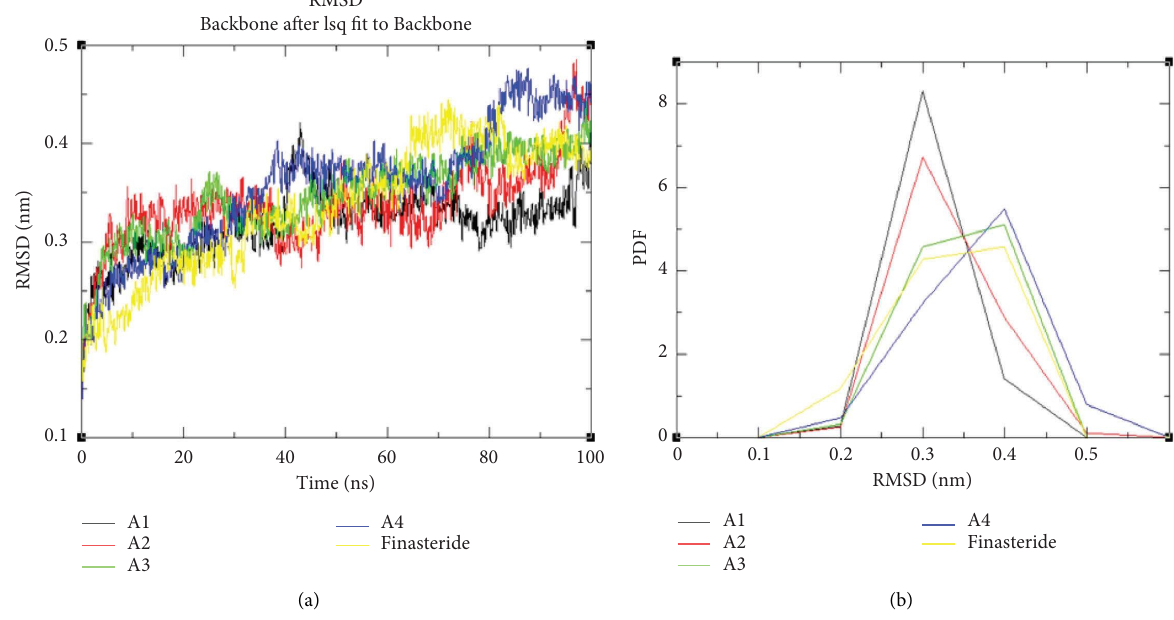
Figure 5: Te RMSD analysis of 100ns trajectory of the protein-hit complexes with fnasteride as the control: (a) RMSD for all the complexes; (b) PDF of RMSD for all the complexes.